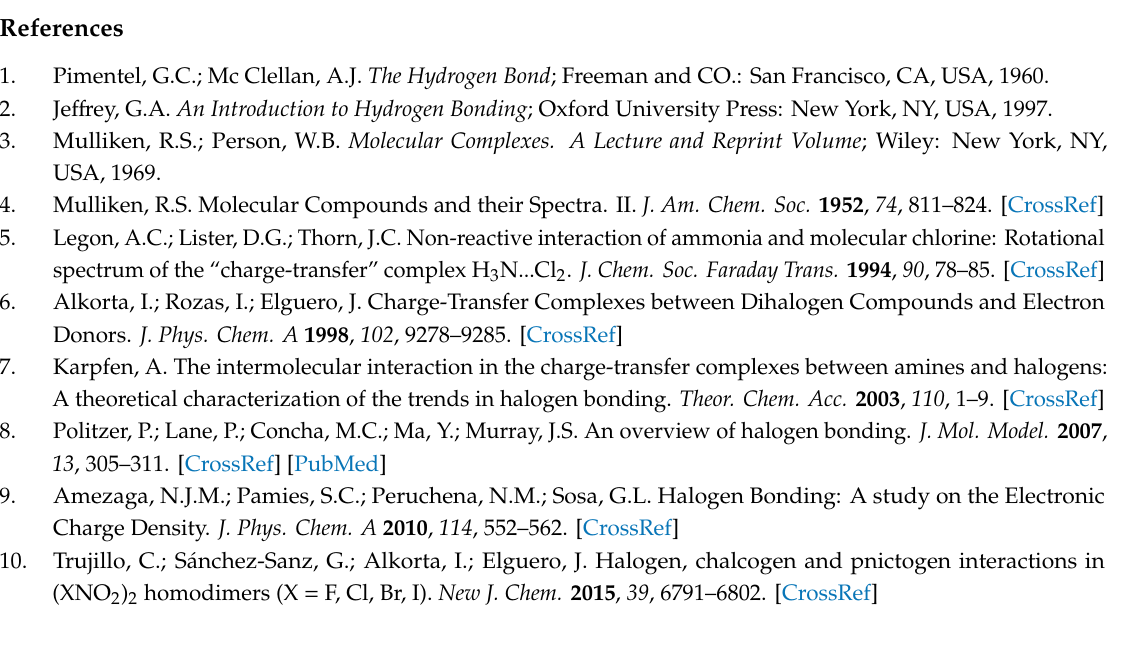
Supplementary Materials: The following are available online, Figure S1 showing the optimized geometry of the D complex between pyridine and OCS, several correlations presented in S.I. 1, S.I.3, S.I.5, Tables S.I.2, S.I.4, S.I.6 listing SAPT results of the A, B and C complexes and Table S.I.7 presents the Gibb’s free energy values of A, B and C